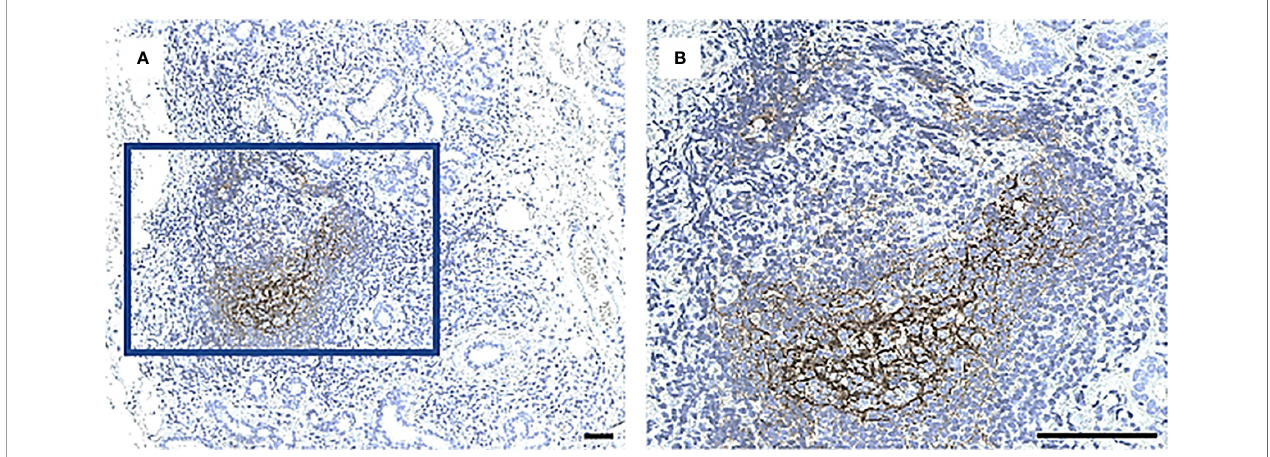
FIGURE 2 | A CD21+ network of follicular DCs in GC in a MSG of a patient with pSS. Staining with CD21 antibody performed in all biopsies to identify a characteristic fDC-network formed in the light zone of GC. Image (B) is a magni fi cation of (A) . Scale bar = 0.5